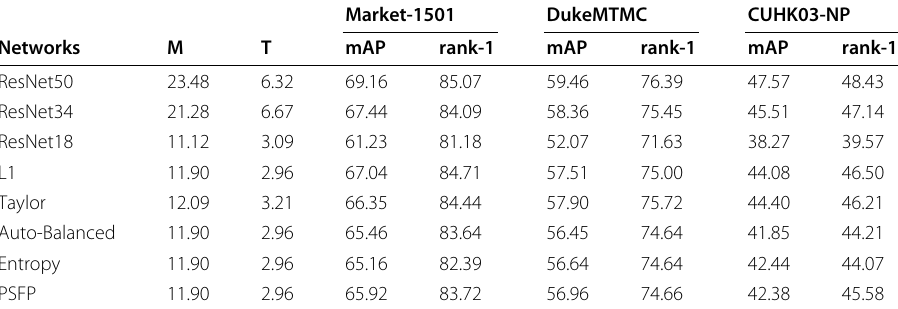
Table 5 Accuracy (mAP and rank-1:R-1) and complexity (M: parameters and T: GFLOPS) of baseline and pruning Siamese networks on ReID datasets